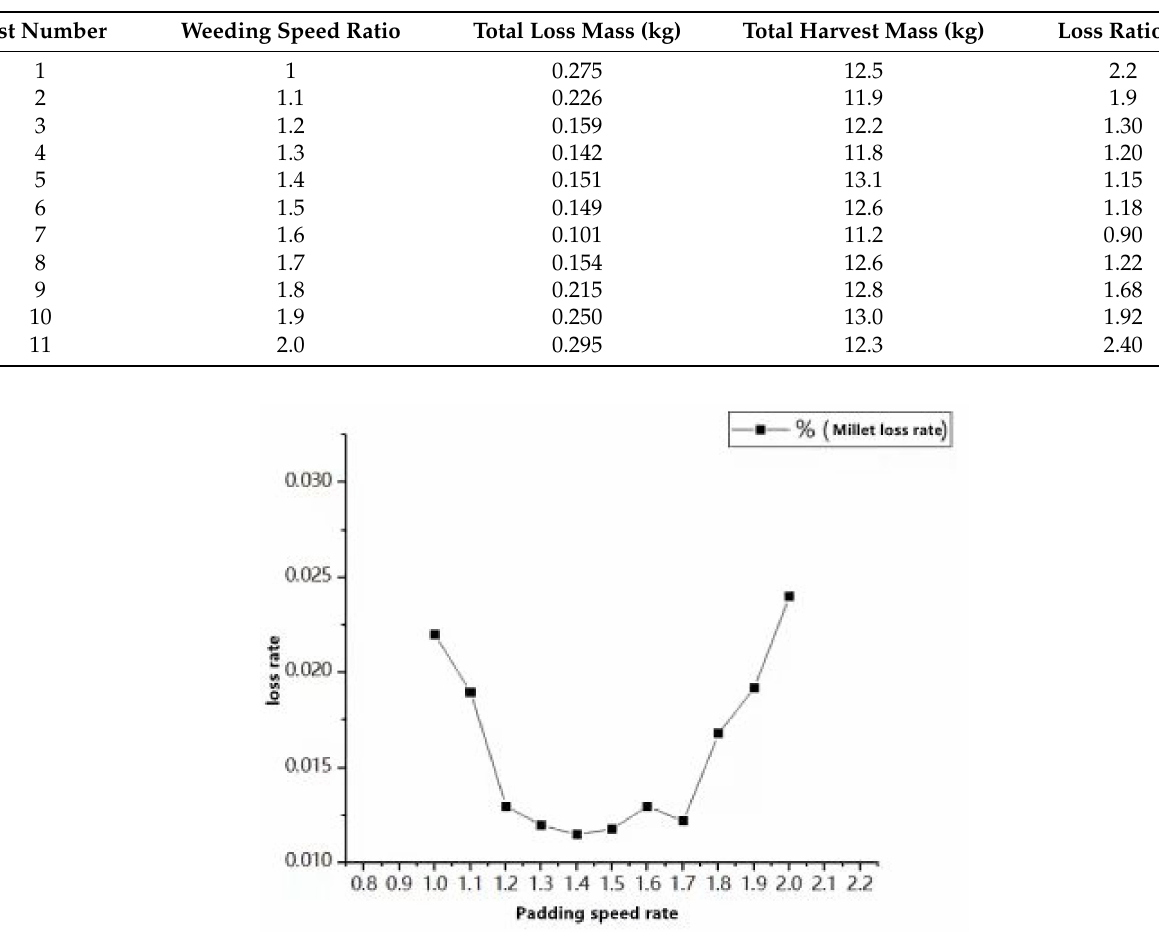
Figure 4. Line chart of rice loss rate. Table 2. Table of millet loss rate.